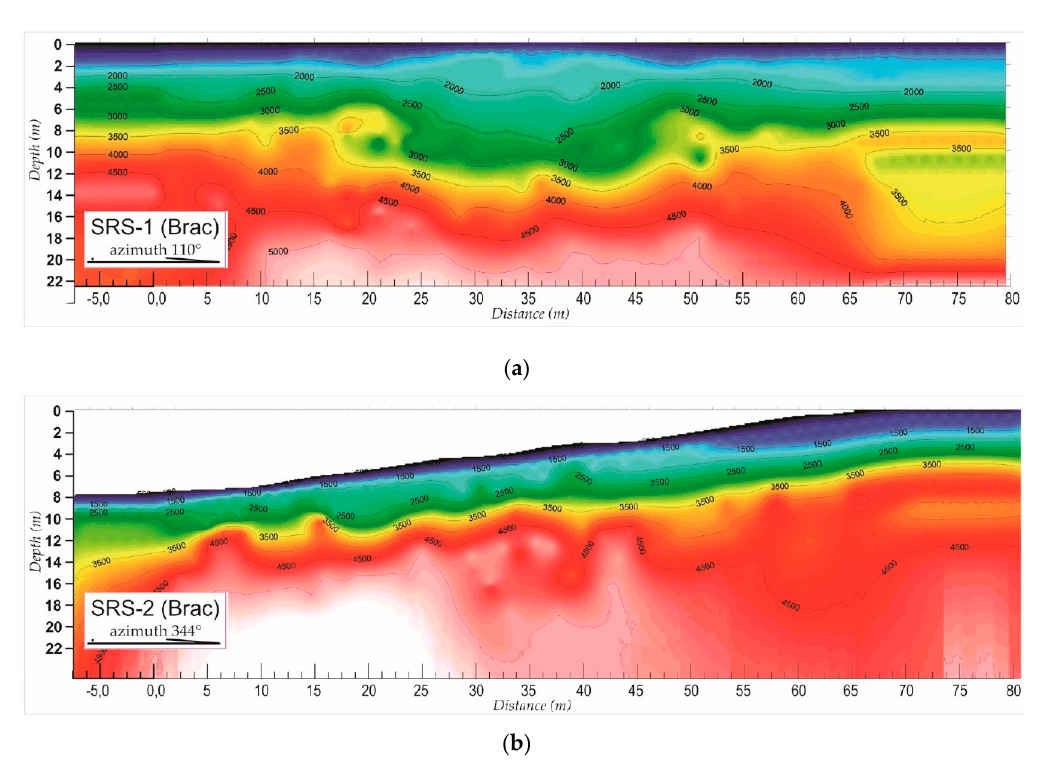
Figure 8. Models of compressional wave velocities (V p ), interpreted from shallow refraction seismic (SRS). ( a ) Deeper weathering zones could be observed on the central part of the seismic profile V p =2000–3500 m/s; ( b ) Refraction seismic profile, with rock quality layers following slope inclination and bedrock compressional wave velocity higher than V p =4500 m/s.